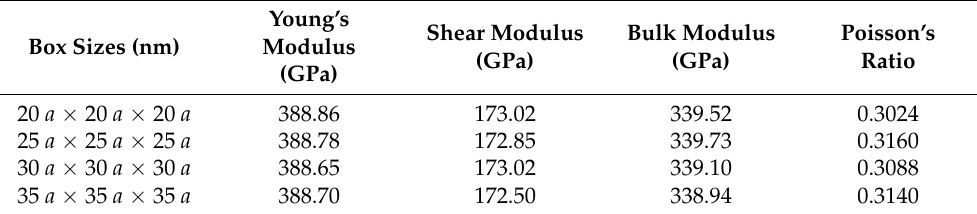
Table 1. Young’s modulus, shear modulus, bulk modulus, and Poisson’s ratio for tungsten crystal with different system sizes at pressure of 8 GPa.